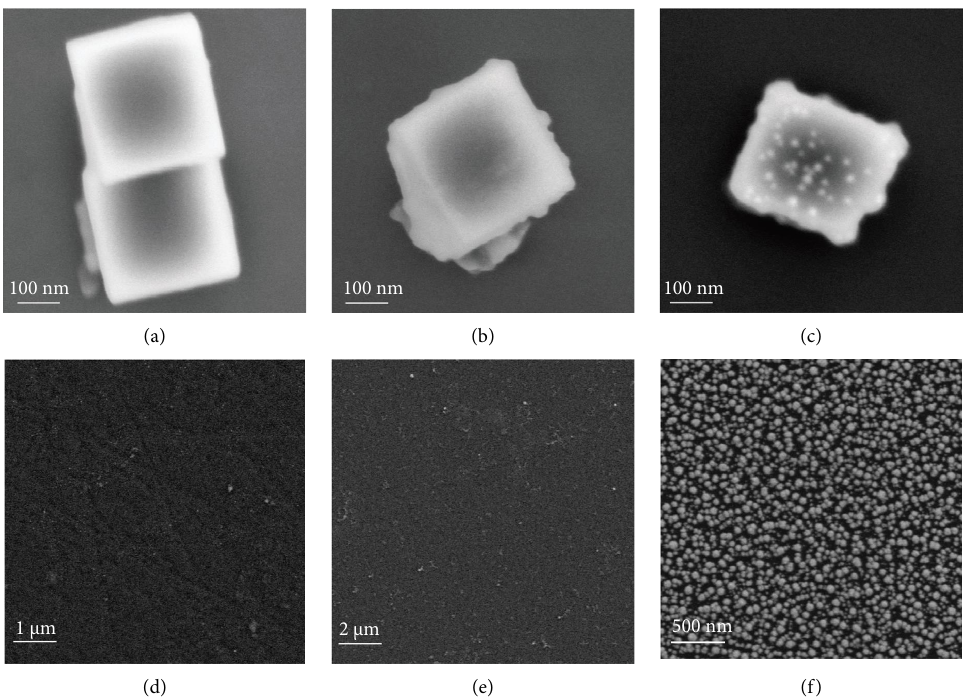
Figure 1: (a) SEM images of PB, (b) PB@PANI, (c) Au NPs-PB@PANI, (d) GCE, (e) L-Cys/GCE, and (f) AuPt NFc/L-Cys/GCE.